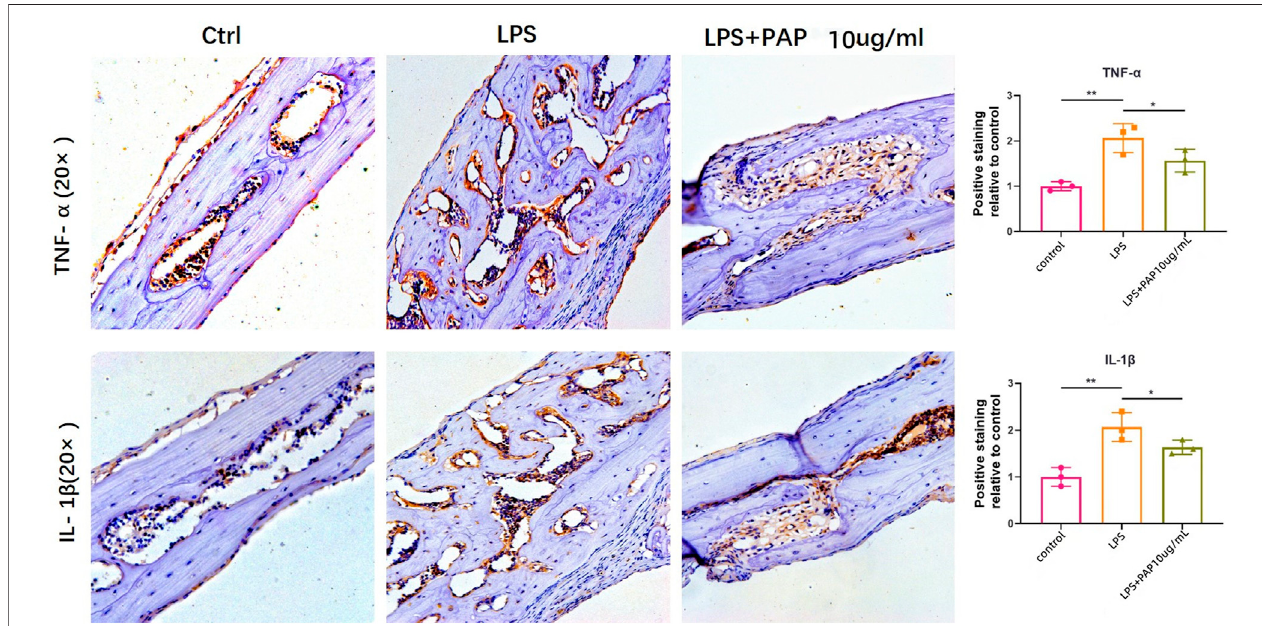
FIGURE 6 | Immunohistochemical staining of in fl ammatory cytokines. Numbers of TNF- α or IL-1 β -positive cells in the cranium of mice treated with lipopolysaccharide (LPS) with or without PAP were quanti fi ed. **p < 0.01, *p < 0.05.